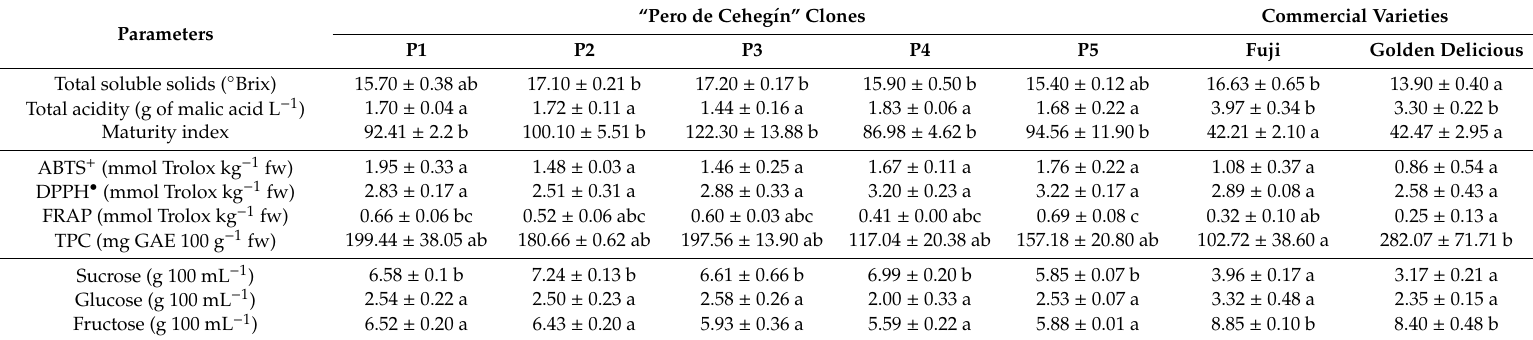
Table 6. Quality parameters, antioxidant activity, contents of total phenolic and sugars in the five clones of “Pero de Ceheg í n” and varieties of reference (“Fuji” and “Golden Delicious”) harvested in